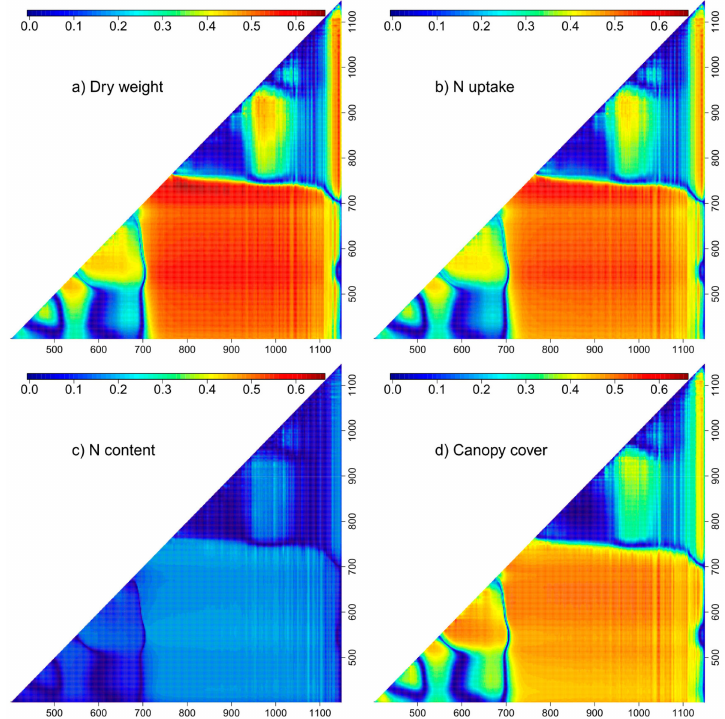
Figure 4. Contour map matrices: Mean squared Pearson correlation coefficients (R 2 ) calculated across the contour maps of the four measurement dates for four target traits. Axis denote spectral bands (nm). For estimating CC, the pattern was similar as for DW, but without peaks in the red edge/NIR range. In contrast to the other traits, a second peak was visible for combinations in the red/red and red/green range (500–680 nm), with the maximum R 2 (0.55) reached by a narrow-banded spectral combination at 584 nm; 582